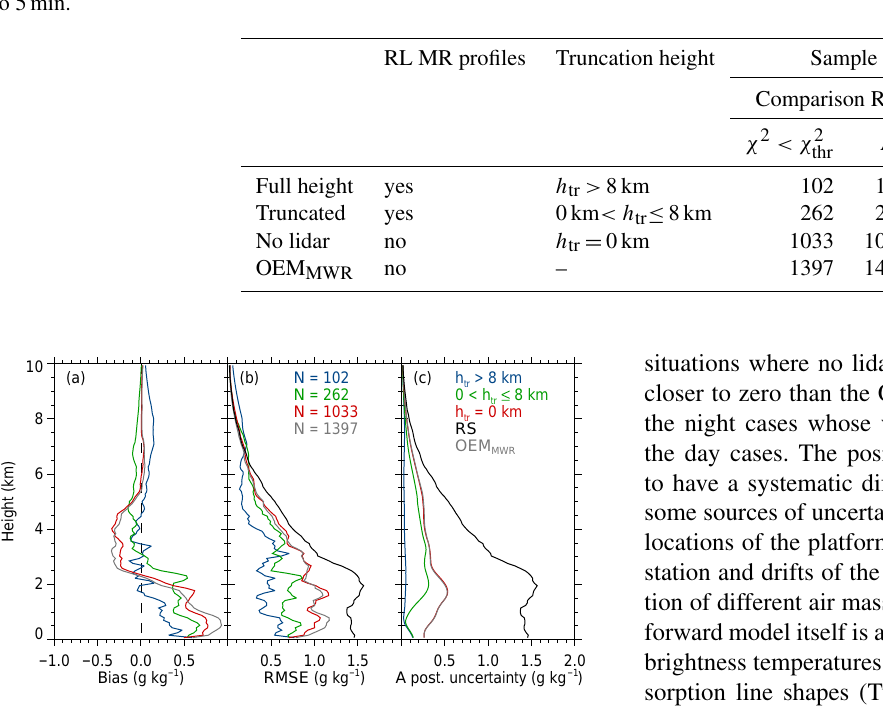
Figure 14. Statistical analysis of the synergy improvement: mean difference (bias) between the retrieval and the RS (a) , root mean square error (RMSE) to RS (b) and a posteriori uncertainty (c) . It distinguishes four situations according to Table 2. The sample size is given by the numbers in the middle panel. Only profiles between RS launch time and 1h after are